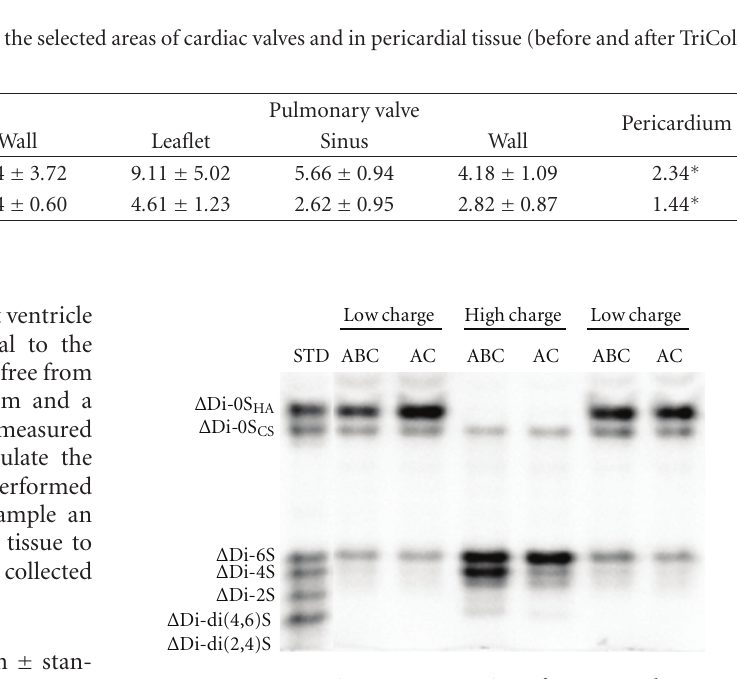
Figure 1: Representative FACE separation of unsaturated AMAC- labeled disaccharides obtained from low- (0.55 M NaCl) and high- charged (1M NaCl) GAGs after depolymerization with Chase ABC and